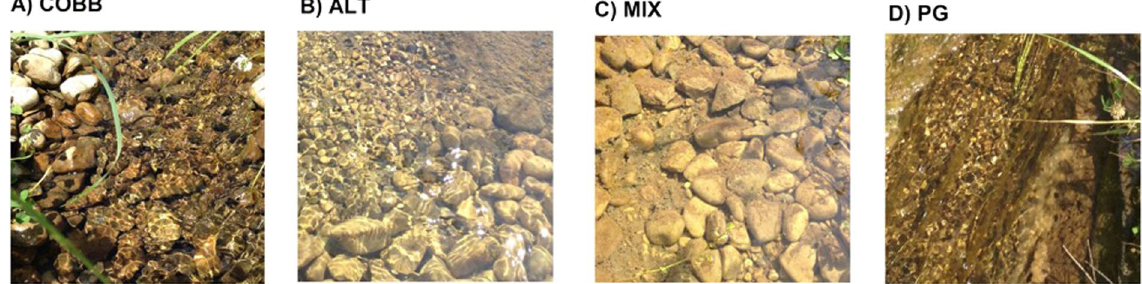
Figure 2. Pictures of COBB ( A ), ALT ( B ), MIX ( C ), and PG ( D ) ND LEEF streams in August 2014, after ~60 days of biofilm